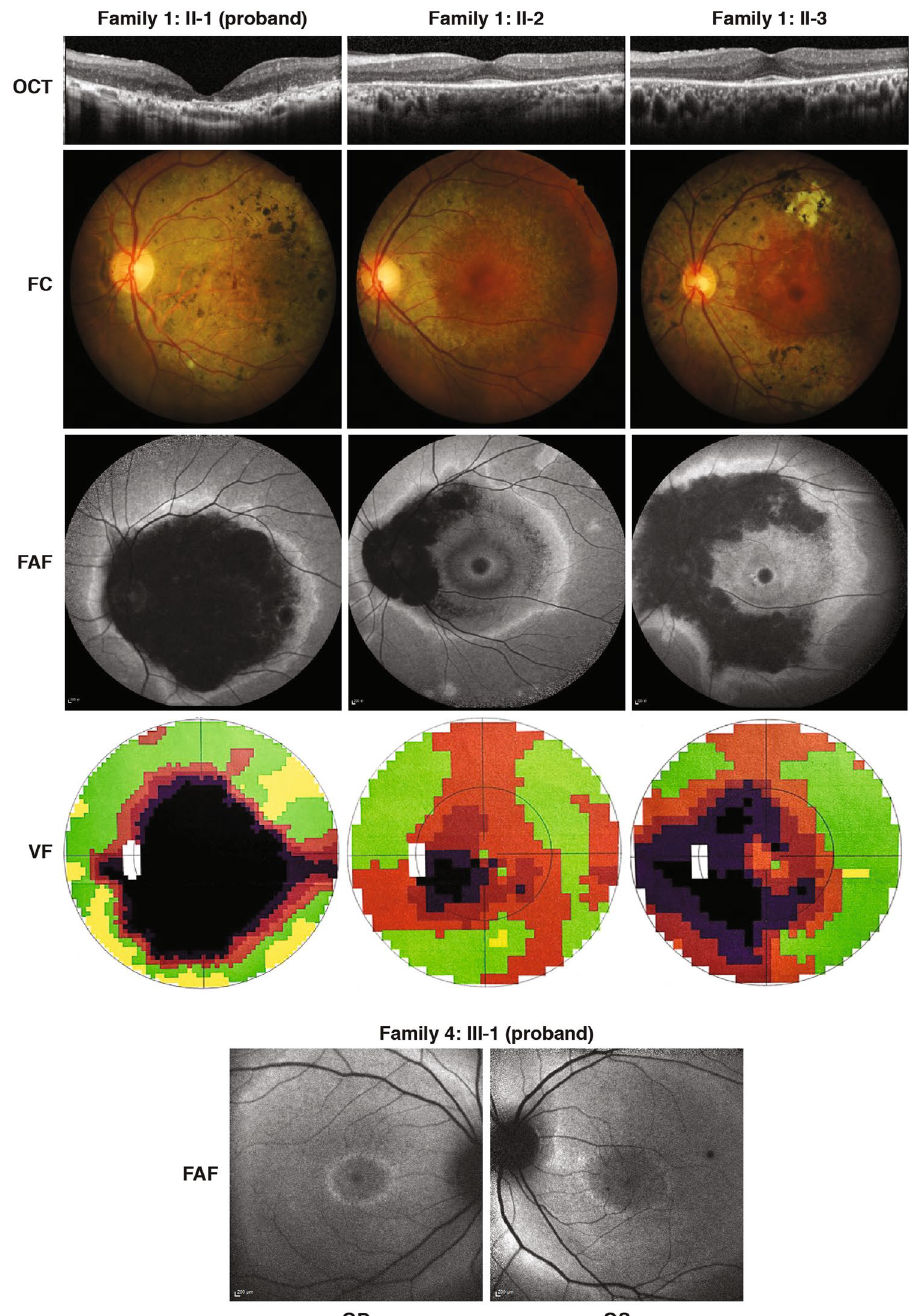
Figure 2. The clinical phenotypes of the patients. The phenotypes of the three affected individuals in Family 1 and the proband in Family 4. OCT, optical coherence tomography; FC, ophthalmoscopy; FAF, fundus autofluorescence; VF, visual field. OD, the right eye; OS, the left eye. Note all the pictures for Family 1 show the phentoypes of the left